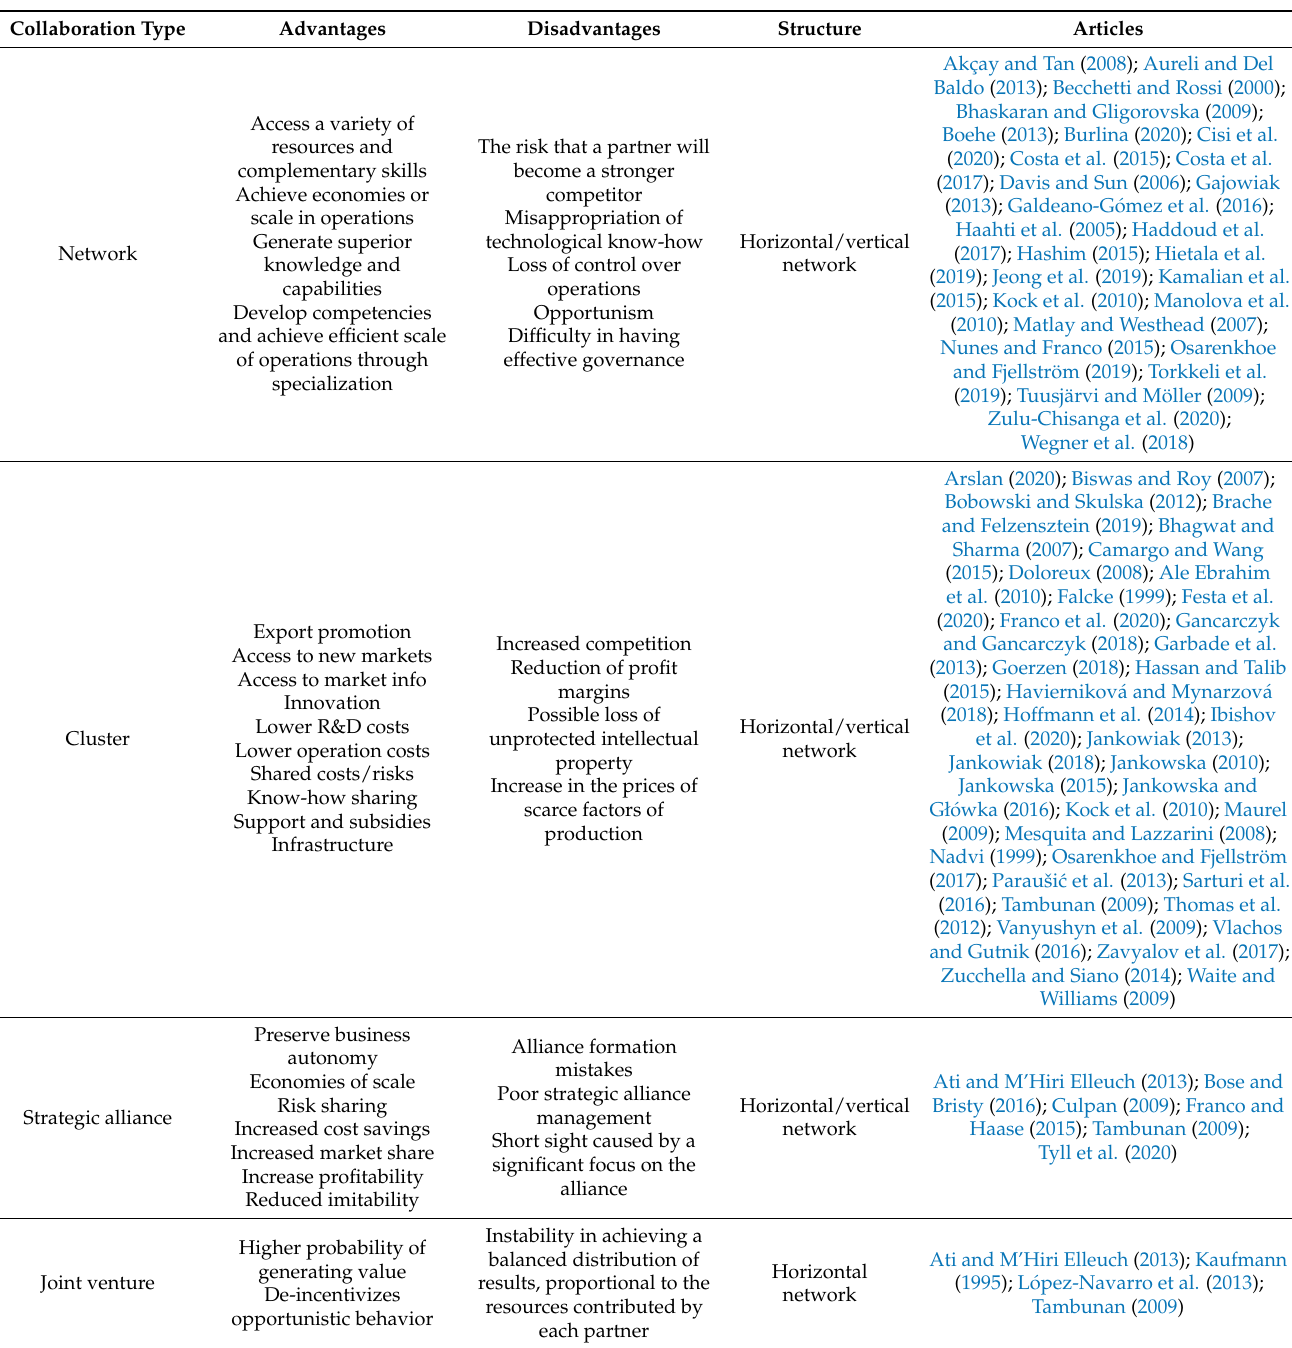
Table 3. Types of collaboration among